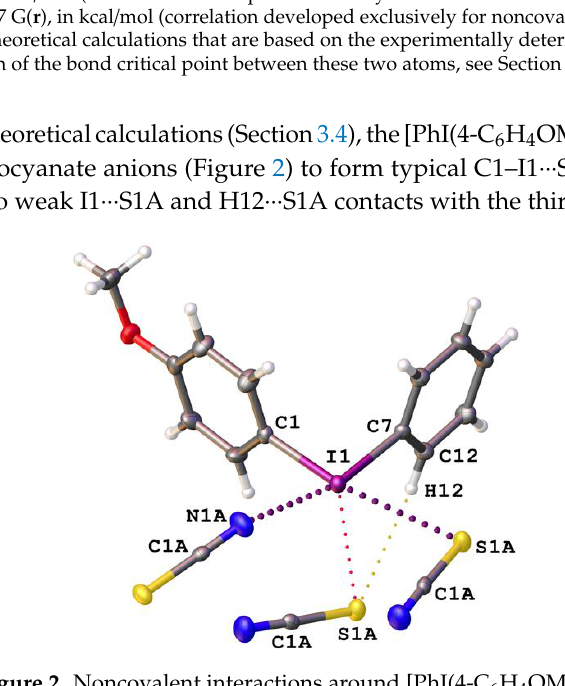
Figure 2. Noncovalent interactions around [PhI(4-C 6 H 4 OMe)] + .